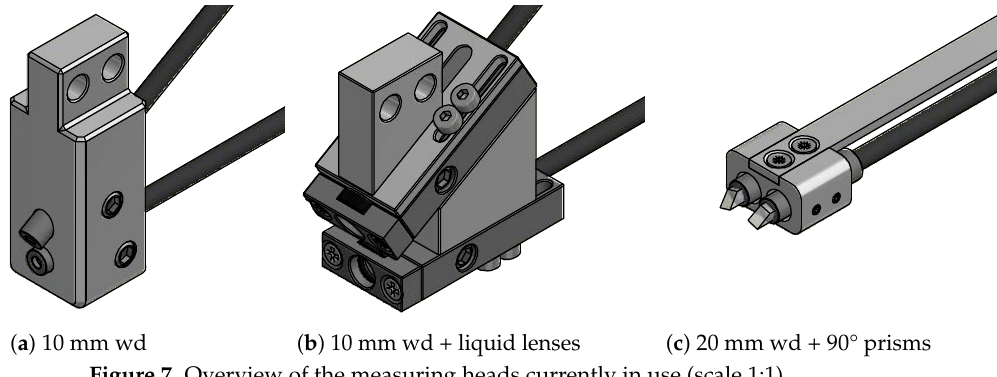
Figure 7. Overview of the measuring heads currently in use (scale